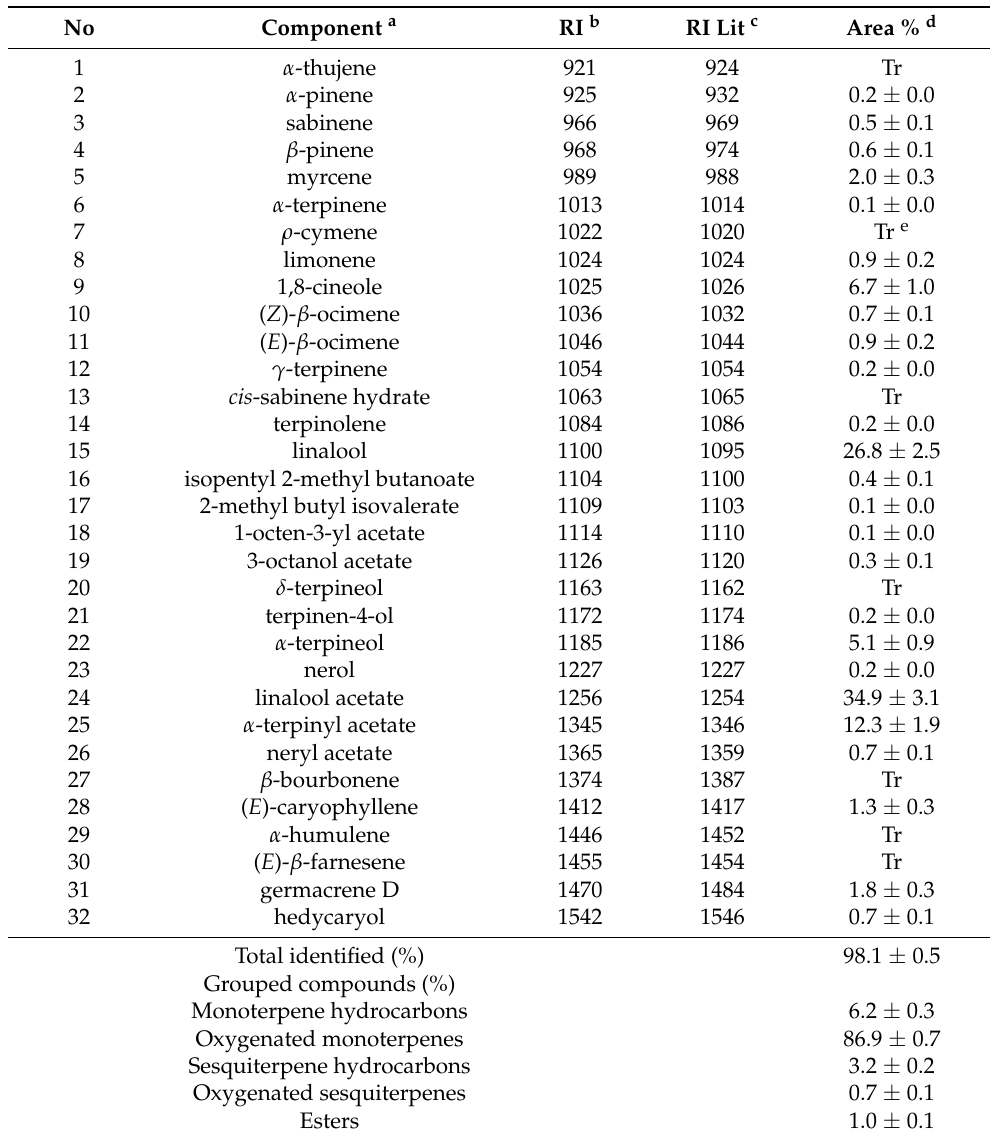
Table 1. Chemical composition of Mentha aquatica essential